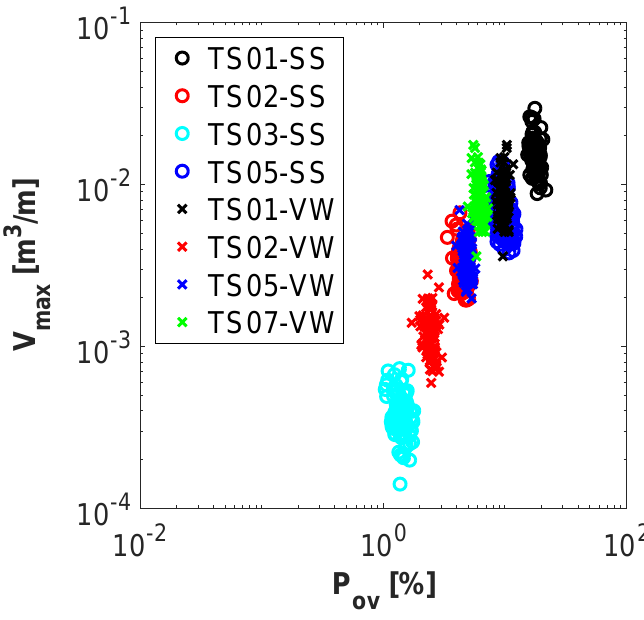
Figure 9. Graph showing P ov plotted against V max for a random seeding test with both